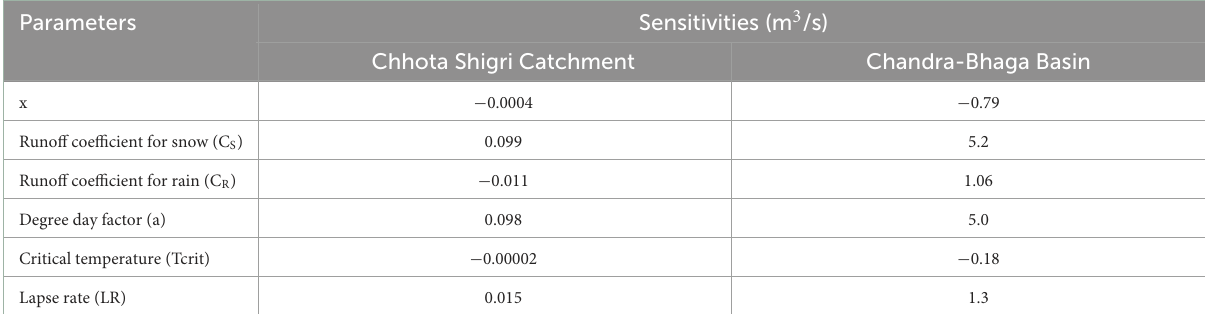
TABLE 3 List of model parameters and their sensitivities for the Chhota Shigri Catchment and Chandra Bhaga Basin (Case-III).